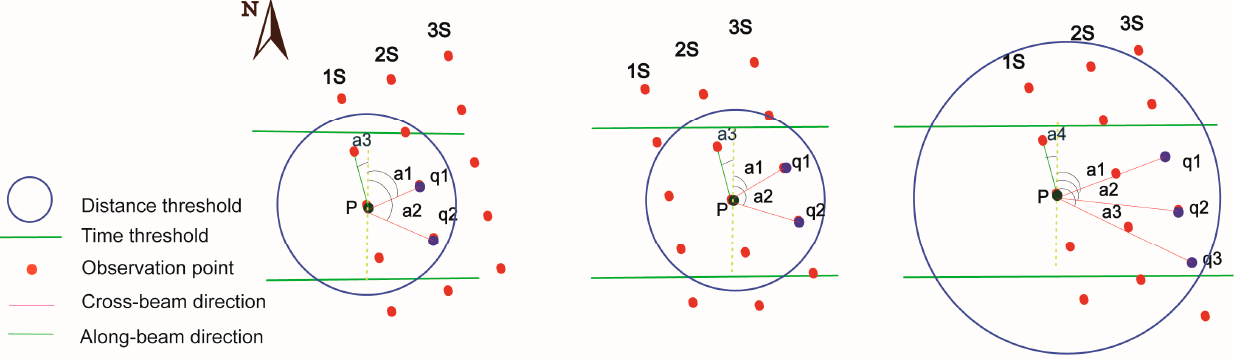
Figure 5. Schematic diagram of calculation method for the joint along-cross beam DOV (‘a1’, ‘a2’, ‘a3’ and ‘a4’ is the azimuth of two adjacent observation points).